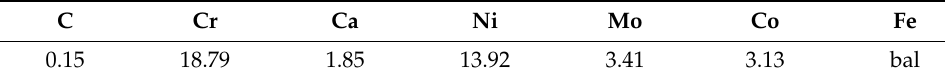
Table 4. Chemical composition of Fe-based alloy powder (wt%).